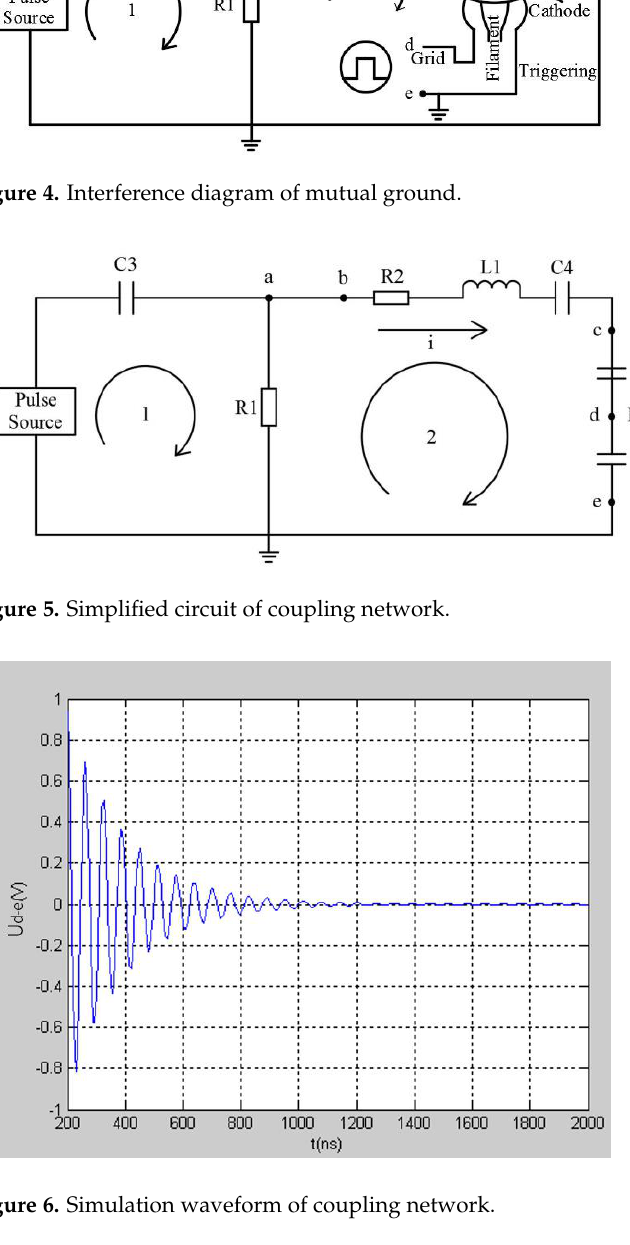
Figure 5. Simplified circuit of coupling network.